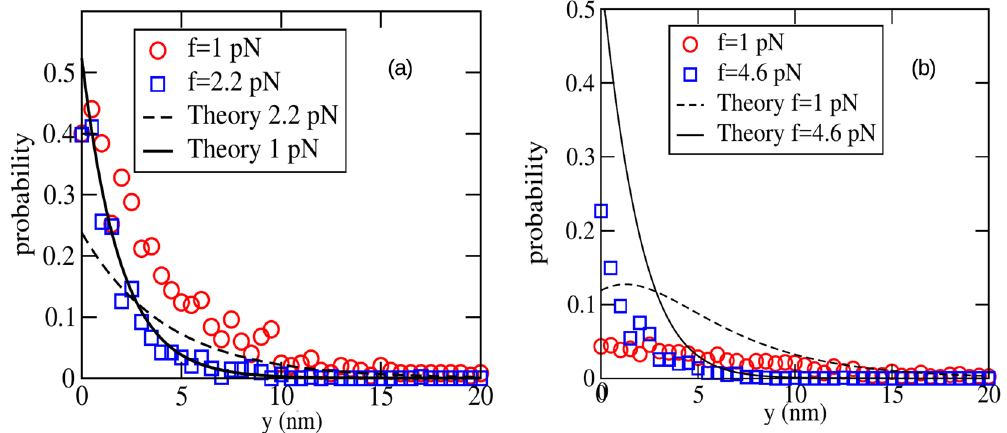
Figure 6. The gap distribution for a = 2 nm, for two forces, far and near to stall. ( a ) is shown for N = 1 and ( b ) is shown for N = 2. A fit of the analytical results (Eq. 28 for N = 1 and Eq. S43(Supplementary Information) for N = 2) also shown for the best fitting value of λ = 0.4 nm − 1 , with k on ( ∞ ) = 0.73 s − 1 . For both ( a ) and ( b ), k off = 0.2 s − 1 . The other parameter values are listed in Table